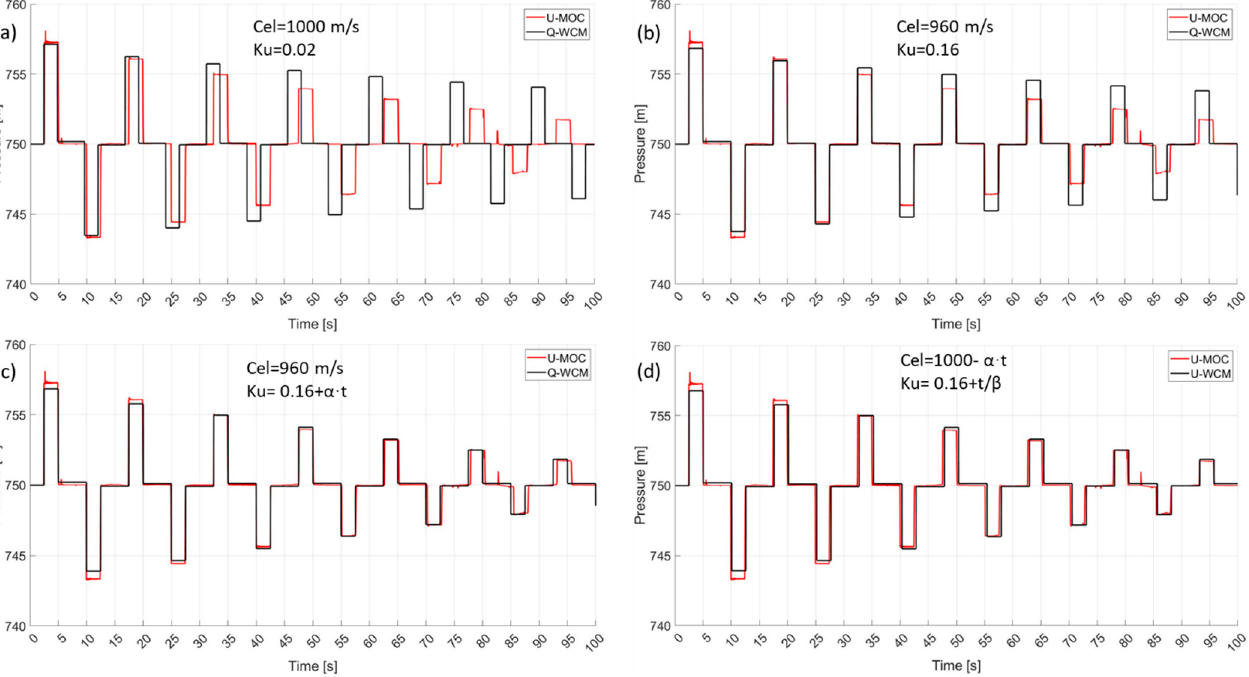
Figure 3. The transient response at node 2 with different WCM tunings, in comparison to the unsteady MOC model in red, for the first case study. The subfigures depict in black the WCM transient evolution from quasi-state friction ( a ) to unsteady friction ( d ), in an ascending order.